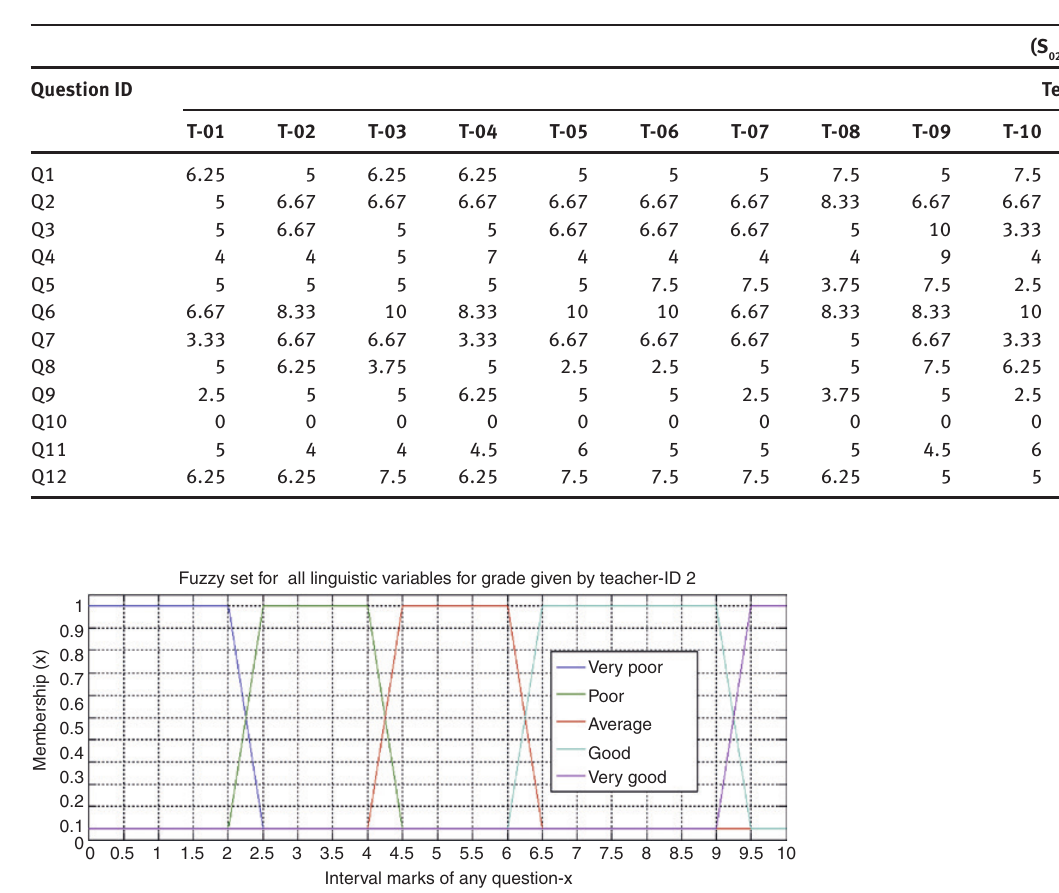
Figure 5: Typical Fuzzy Sets Represented by Teacher ID-02 Representing Expert’s Satisfaction